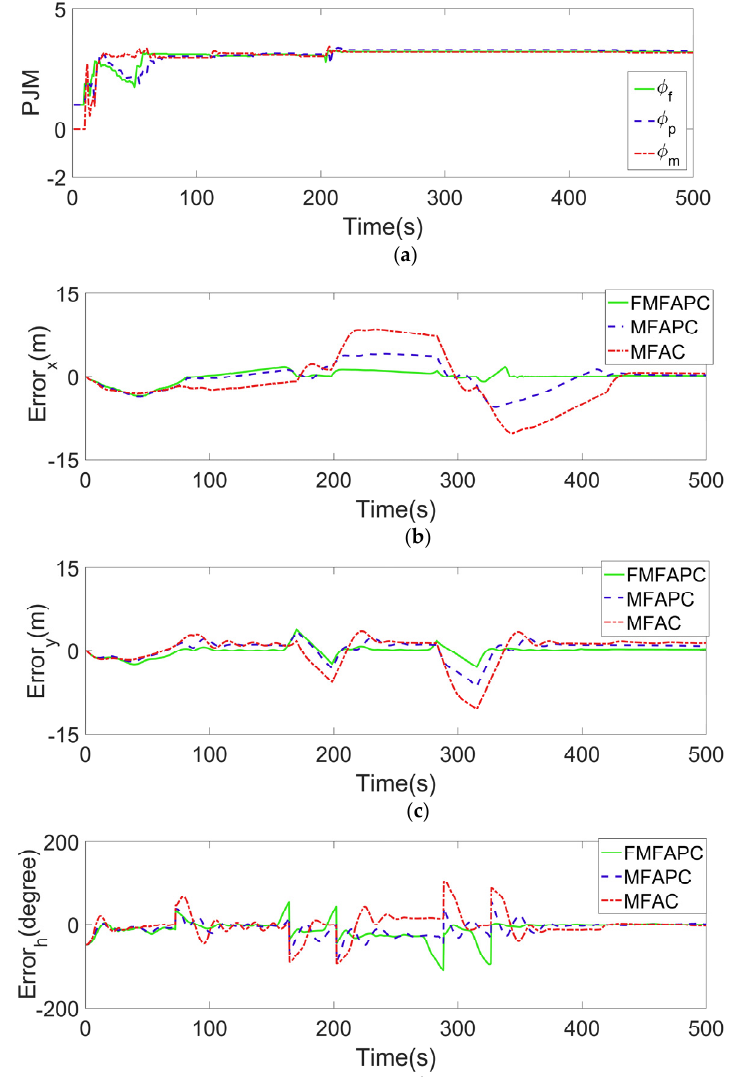
Figure 2. ( a ) PJM estimation results of controllers. ( b − d ) Tracking errors. Table 3. STD and MAD of controllers under Scenario